Question: Sum up the contents of this chart in one sentence.
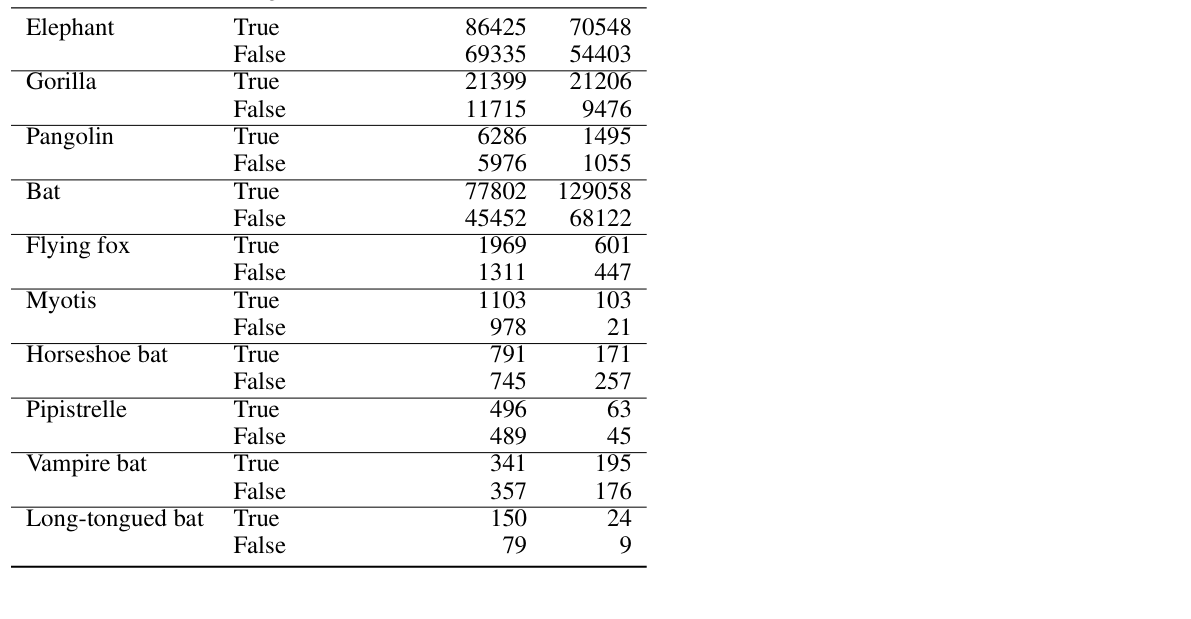
Answer: shows the distribution of topics associated with relevant articles for different taxa.